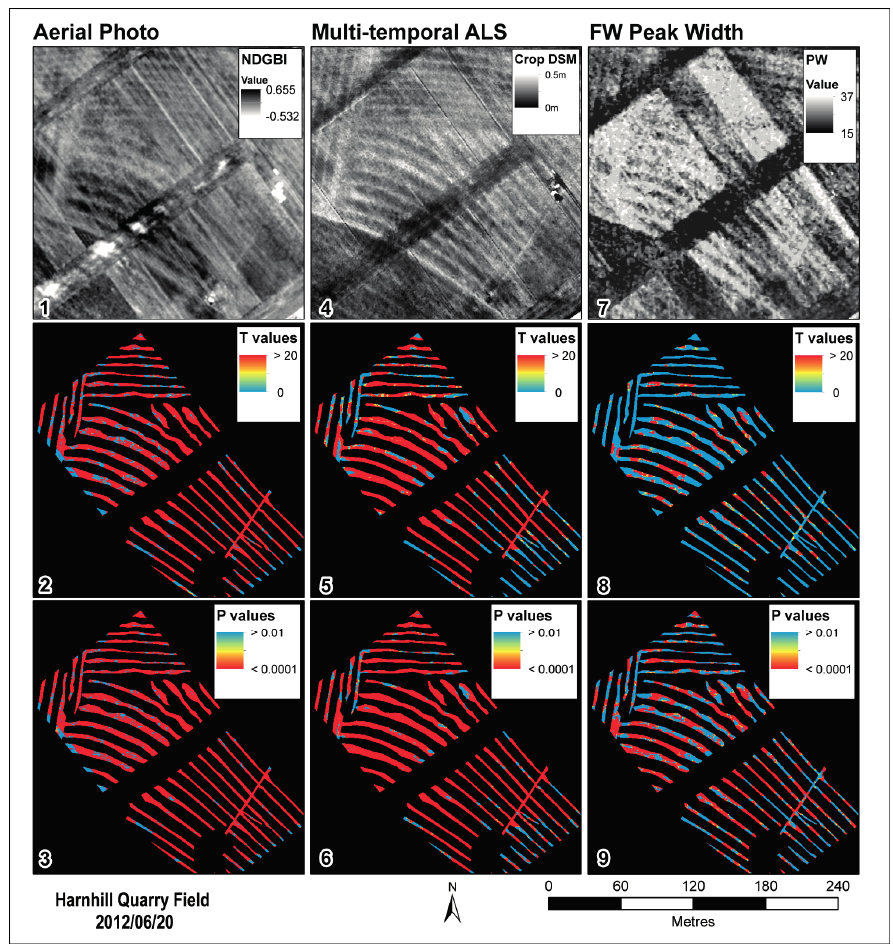
Figure 14. Harnhill Quarry field—Comparison between aerial photography, multi-temporal derived CHM and FWF metric data. T -values and P -values indicate localised